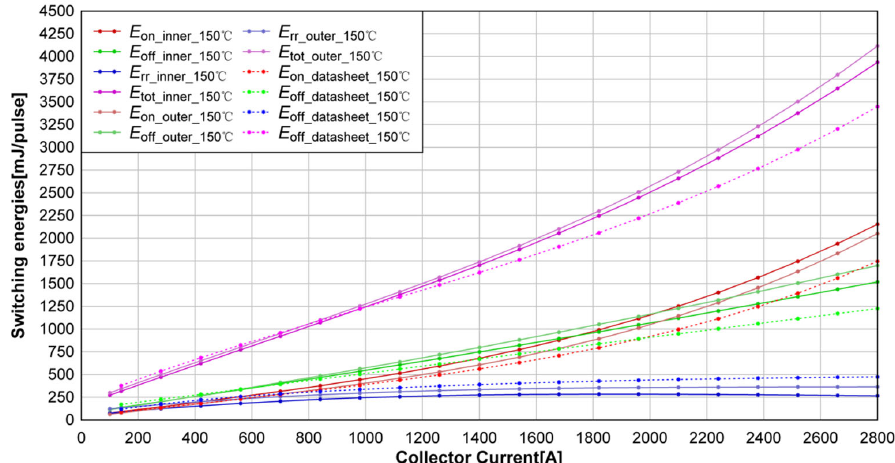
Figure 28. IGBT switching energies between the inner commutation path, the outer commutation path, and data given by datasheet at 150 °C.